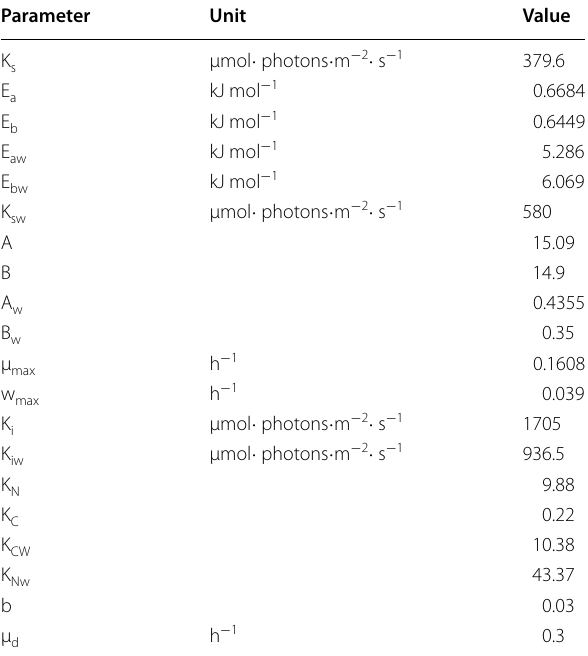
Table 1 Parameters based on average light